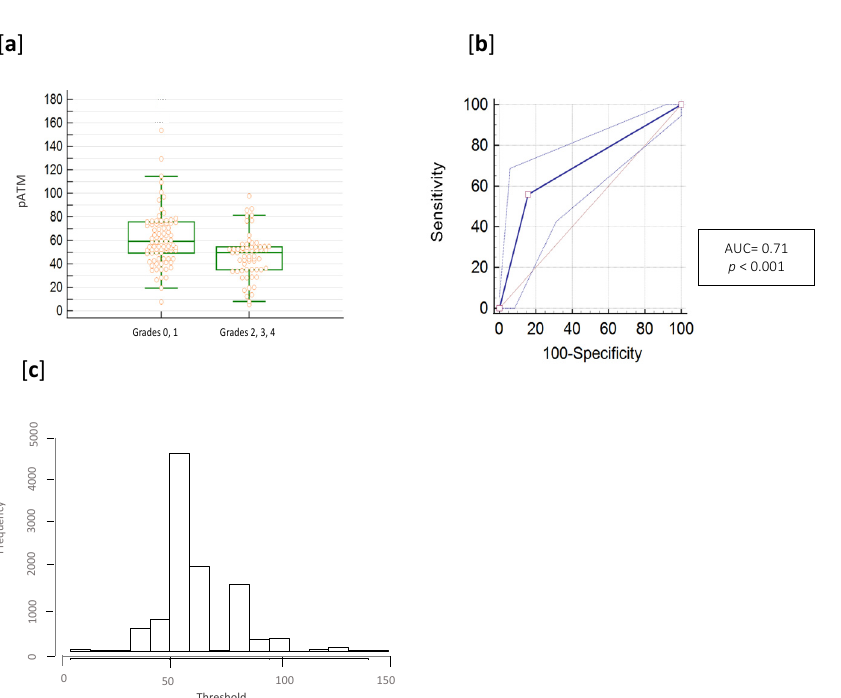
Figure 1. Determination of the optimized threshold and prediction results of the 150 patients. ( a ) pATM ELISA assay distribution (pATM quantities are in ng/mL). ( b ) ROC analysis was performed on pATM ELISA results and a Wilcoxon rank sum test was also applied to compare RR and RS groups ( p < 0.001). ( c ) Histogram of threshold frequencies after the bootstrap analysis.